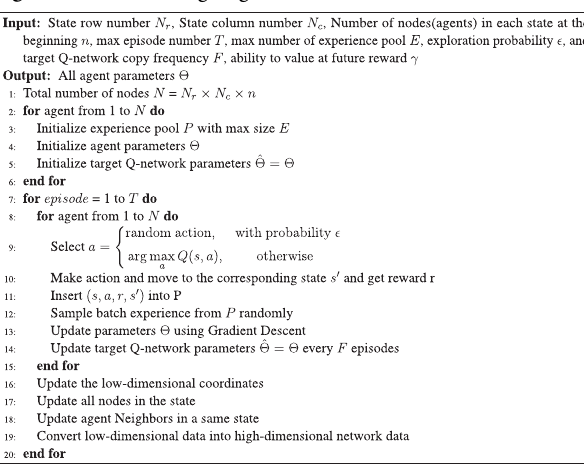
Algorithm 1. Training Algorithm of the NMDRL.